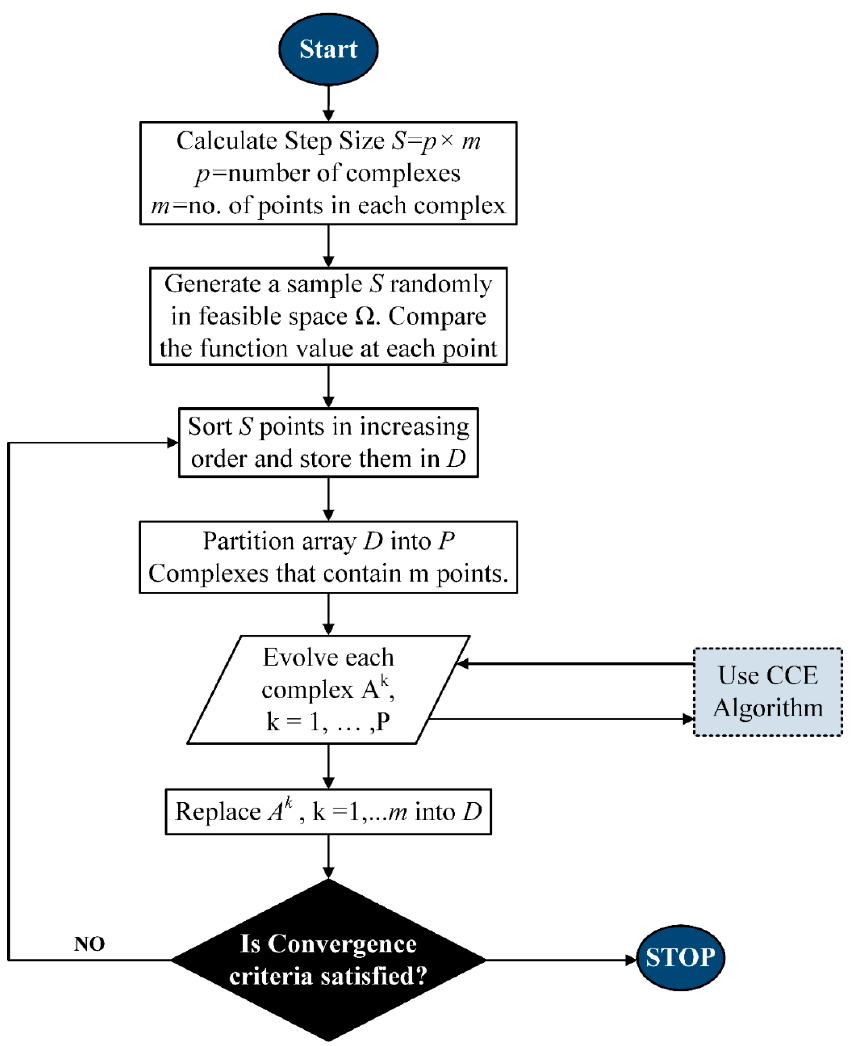
Figure 1. Flow chart of the shuffled complex method .